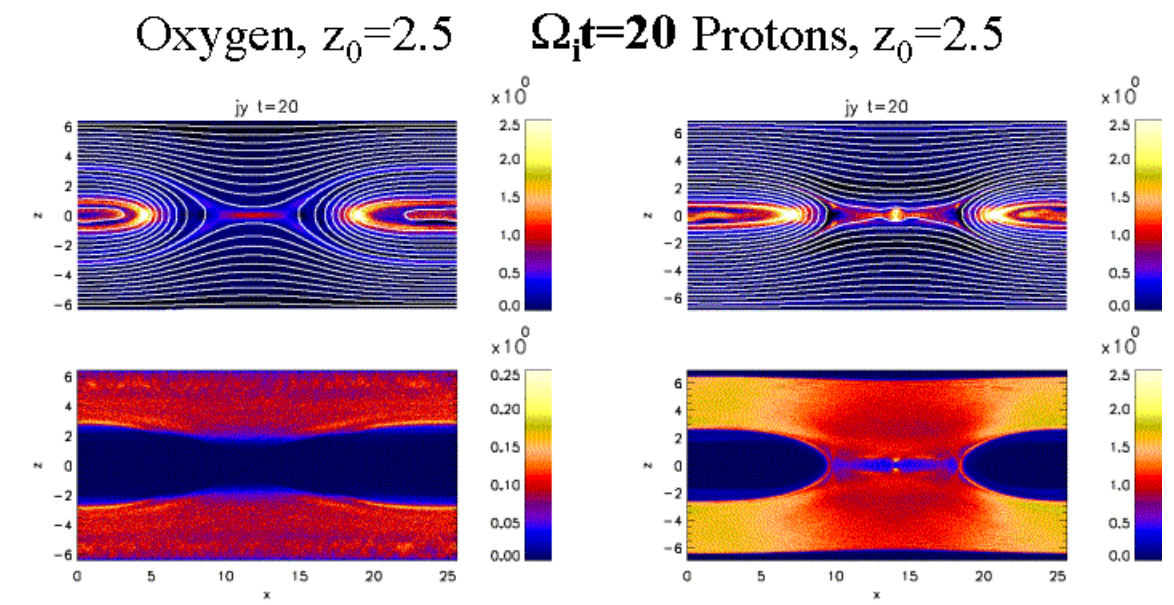
Fig. 3. Comparison of magnetic fields and currents (top panels) and background populations densities for two runs. The runs involve either oxygen (left) or proton (right) background populations, added at | z | > 2 .